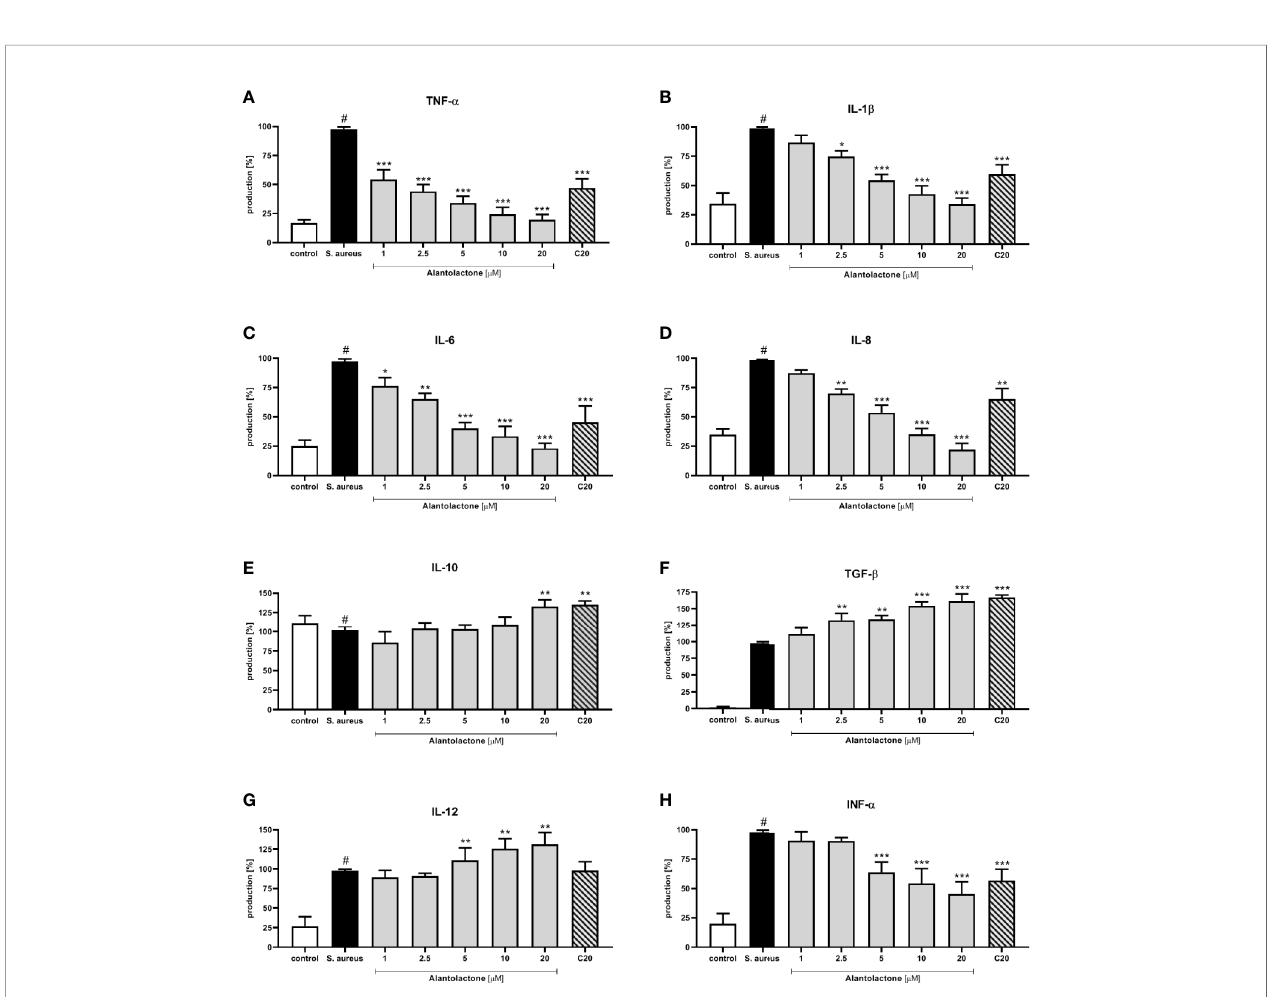
FIGURE 8 | The in fl uence of alantolactone on the pro- and anti-in fl ammatory cytokines production by THP-1 cells (A – H) Statistical signi fi cance: *p < 0.05, **p < 0.01, ***p < 0.001 versus stimulated control (ANOVA and Dunnett ’ s post hoc test); control — non-stimulated control; S. aureus — S. aureus -stimulated control. # statistically signi fi cant (p < 0.001) versus non-stimulated